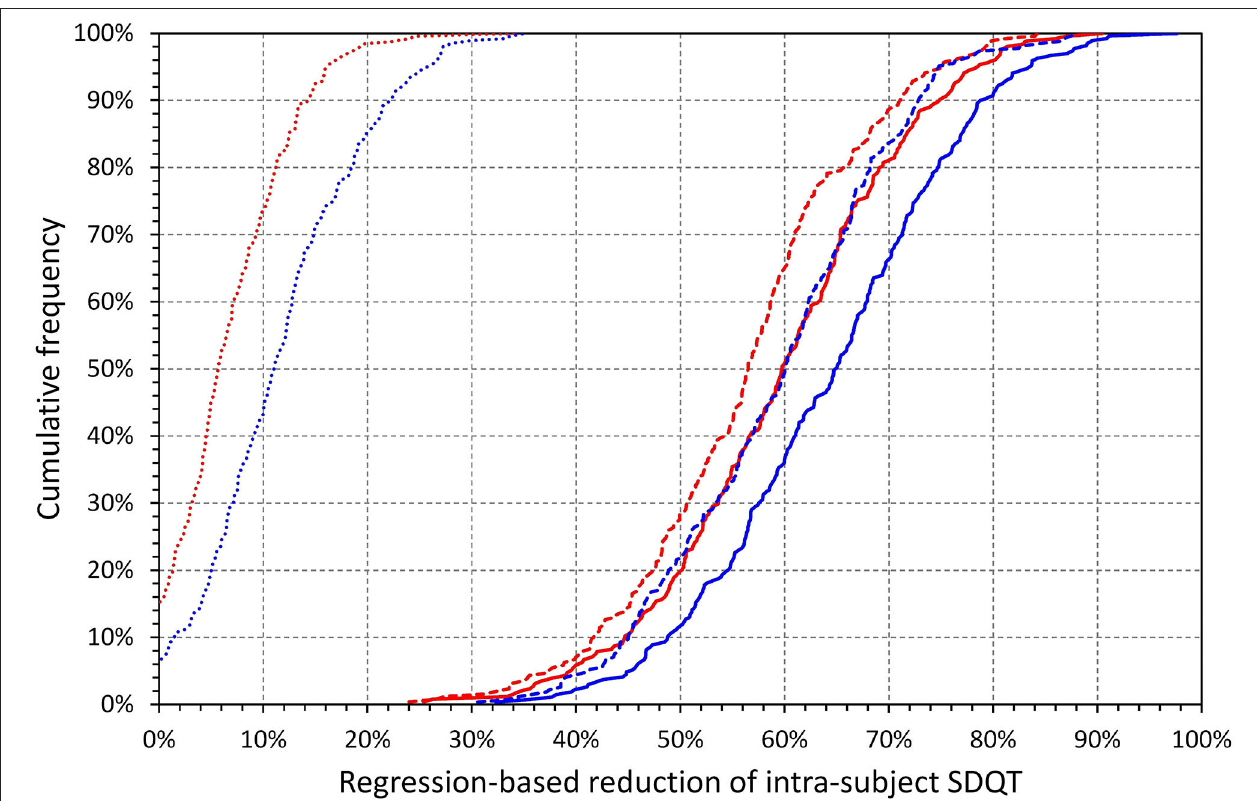
FIGURE 13 | Cumulative distributions of relative decreases of intra-subject regression corrected central SDQT values calculated as a proportion of uncorrected intra-subject means of SDQT (see the section on Statistics and data presentation for details). The reductions by regression correction by SDRR are shown in dotted lines, the reduction by 10-s median beat noise in dashed lines, and the reduction by a regression combination of both SDRR and 10-s median beat noise by solid lines. The red and blue lines correspond to females and males,